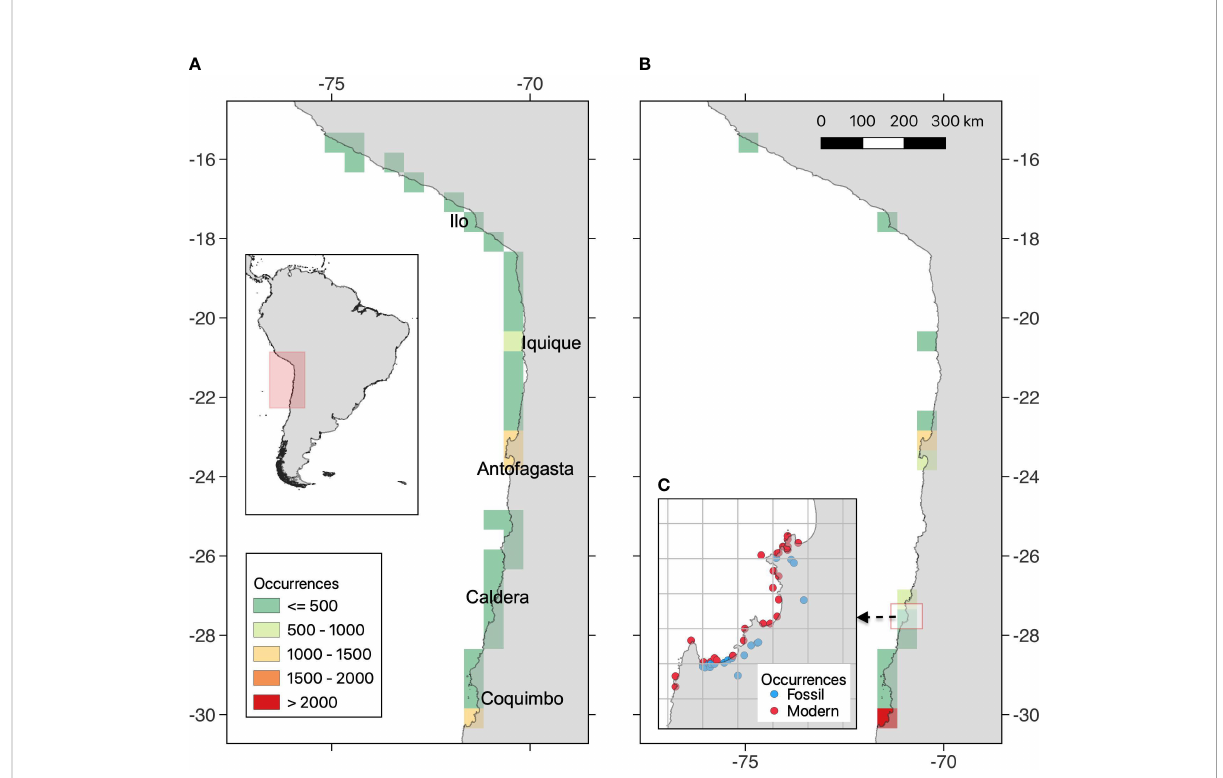
FIGURE 1 Map of the study region, in coast of the Humboldt Current Ecosystem, showing the number of georeferenced occurrences for (A) modern and (B) Quaternary fossil assemblages. It is also provided an example of the spatial aggregation scheme, using grids cells of 0.1° (C)